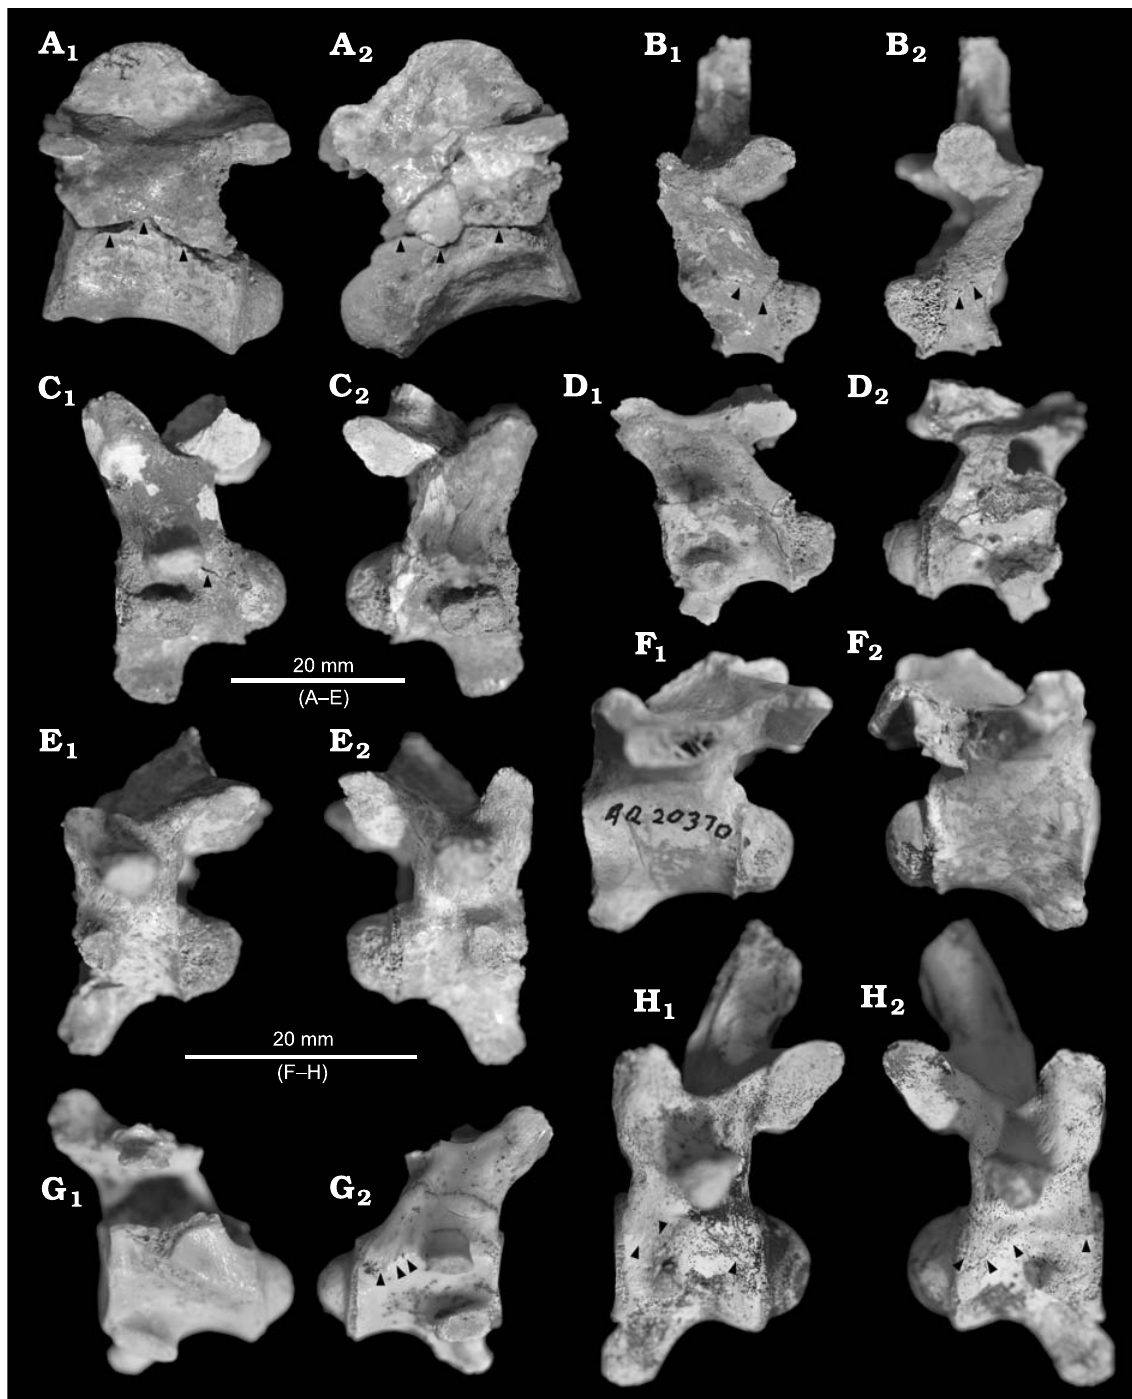
Fig. 2. Vertebrae of mekosuchine crocodile Mekosuchus whitehunterensis Willis, 1997; White Hunter Site, Riversleigh World Heritage Area, northwest- ern Queensland, Australia; late Oligocene. A . Axis vertebra (QM F56039). B . Third cervical vertebra (QM F56040). C . Fourth cervical vertebra (QM F56041). D . Sixth cervical vertebra (QM F56042). E . Ninth cervical vertebra (QM F56043). F . Third thoracic vertebra (QM F56321). G . Third cervical vertebra (QM F56320). H . Eighth cervical vertebra (QM F56322). Arrows indicate extent of the neurocentral suture; left (A 1 –H 1 ) and right (A 2 –H 2 )